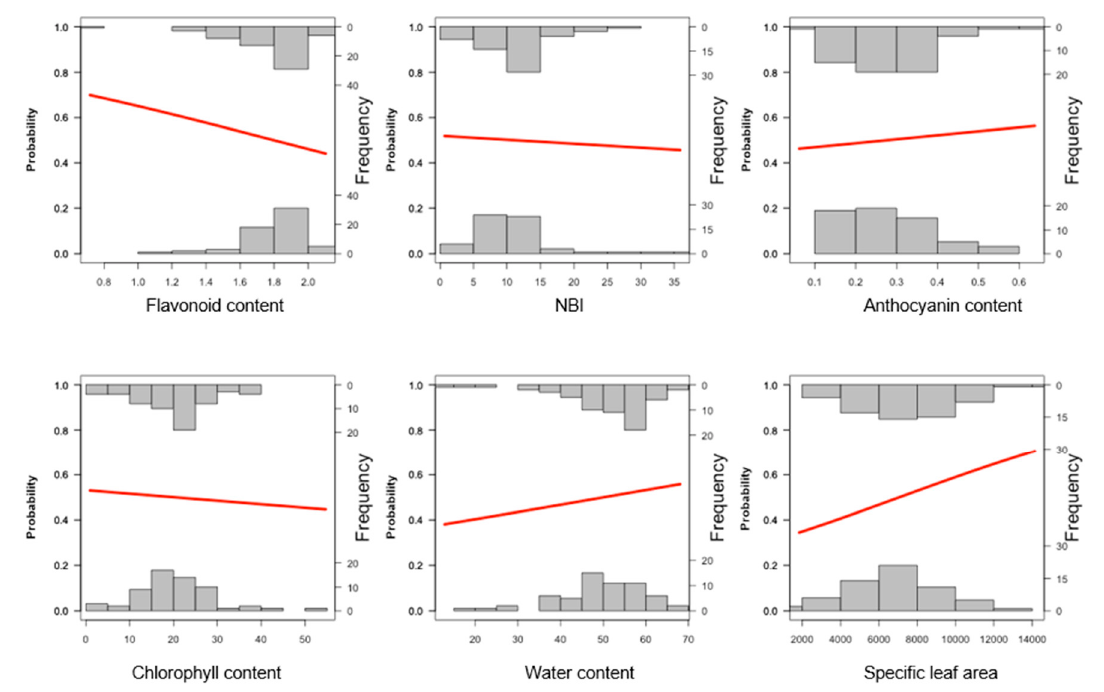
Figure 4. Fitted logistic regression curves showing the predicted probability of gall presence across the study physiological variables. The histograms represent the observed data (1 = galled leaf; 0 = ungalled leaf) and the line shows the predicted probability. n = 64